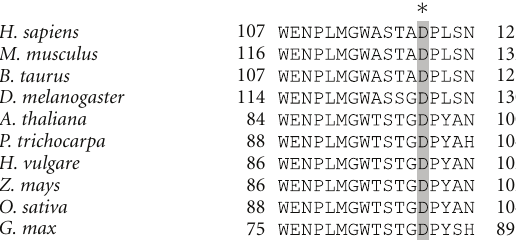
Figure 2: Sequence alignment of NDUFS4 homologues from di ff erent organisms showing the high conservation in the flanking region of D119. The amino acid sequence of Homo sapiens (accession no. NP 002486.1), Mus musculus (accession no. NP 035017.2), Bos taurus (accession no. DAA17925.1), Drosophila melanogaster (accession no. NP 573385), Arabidopsis thaliana (accession no. Q9FJW4), Populus trichocarpa (accession no. XP 002310893), Hordeum vulgare (accession no. BAK01929), Zea mays (accession no. NP 001132398), Oryza sativa (accession no. NP 001060126) and Glycine max (accession no. NP 001235335) are shown. Alignment was performed by using the CLUSTALW2 method (Protein Weight Matrix Blosum, clustering NJ) (http://www.ebi.ac.uk/Tools/msa/clustalw2/). The conserved Asp residue is shown in